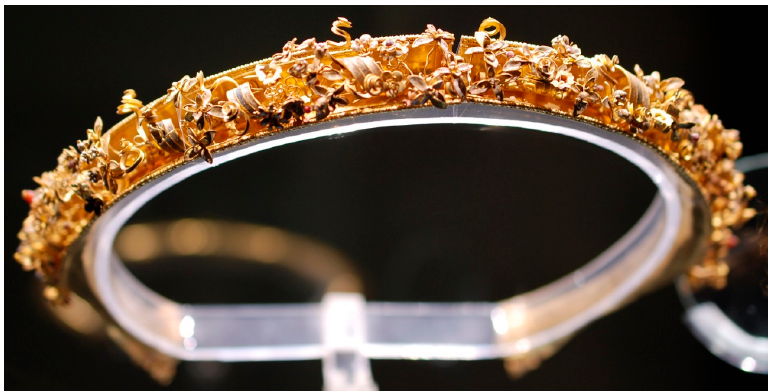
Figure 20. Paestum, Arcioni necropolis: Tomb 271, east slab painted with suspended flower garland over assorted small vases, birds, and a phiale containing eggs (?), ca. 400–375 B.C. Author’s photo.